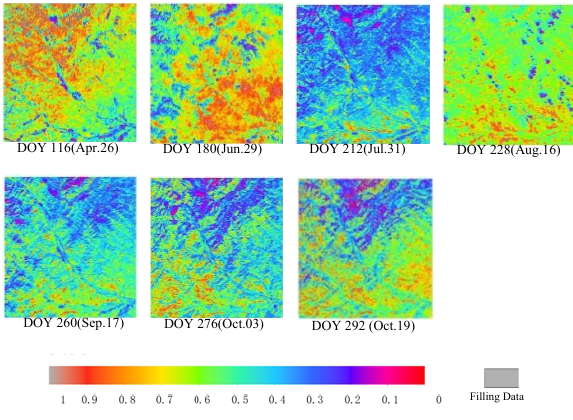
Figure 2. The retrieval TVDI from Landsat 8 OLI data